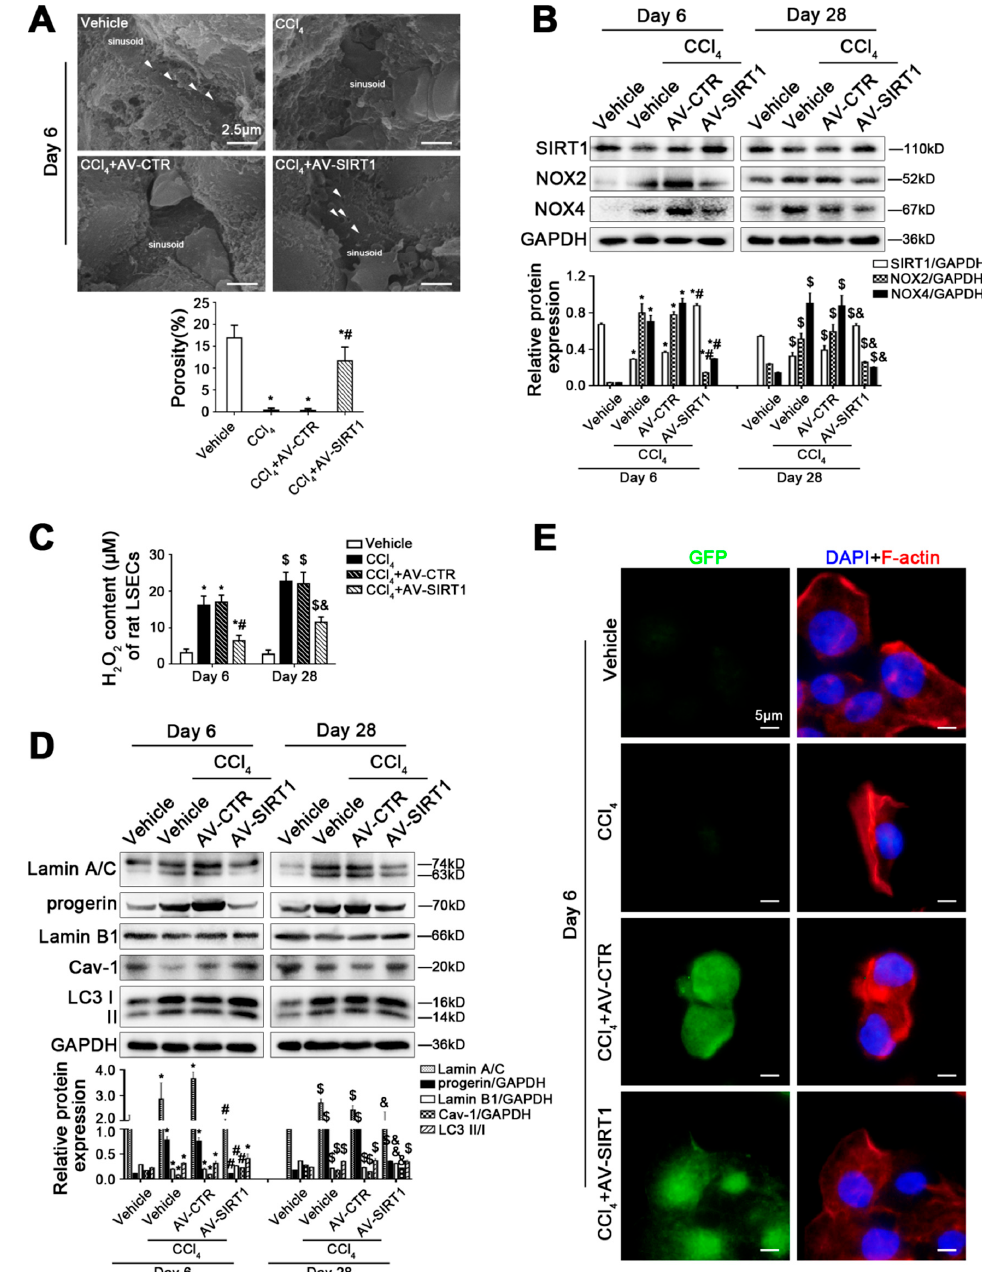
Figure 3. SIRT1 gene transfer to CCl 4 -induced rat models alleviates LSEC defenestration and liver fibrosis through reducing progerin and reversing Cav-1 degradation. ( A ) The magnification of SEM for fenestrae in the liver sinusoidal endothelium of CCl 4 -induced rat models in the four groups (vehicle, CCl 4 , CCl 4 +AV-CTR, CCl 4 +AV-SIRT1) on day 6 (Scale bar: 2.5 µ m). The white triangles indicate fenestrae in liver sinusoidal endothelium. The porosity is quantified in the graph (below). * p < 0.05 versus the vehicle group; # p < 0.05 versus the CCl 4 +AV-CTR group. ( B ) Representative immunoblots of SIRT1, NOX2, and NOX4 in primary LSECs, isolated from CCl 4 -induced rat models on day 6 and day 28. The relative protein expression was quantified in the graph (below). * p < 0.05 versus the vehicle group on day 6; # p < 0.05 versus the CCl 4 +AV-CTR group on day 6; $ p < 0.05 versus the vehicle group on day 28; & p < 0.05 versus the CCl 4 +AV-CTR group on day 28. ( C ) The H 2 O 2 content of primary LSECs, isolated from CCl 4 -induced rat models on day 6 and day 28. * p < 0.05 versus the vehicle group on day 6; # p < 0.05 versus the CCl 4 +AV-CTR group on day 6; $ p < 0.05 versus the vehicle group on day 28; & p < 0.05 versus the CCl 4 +AV-CTR group on day